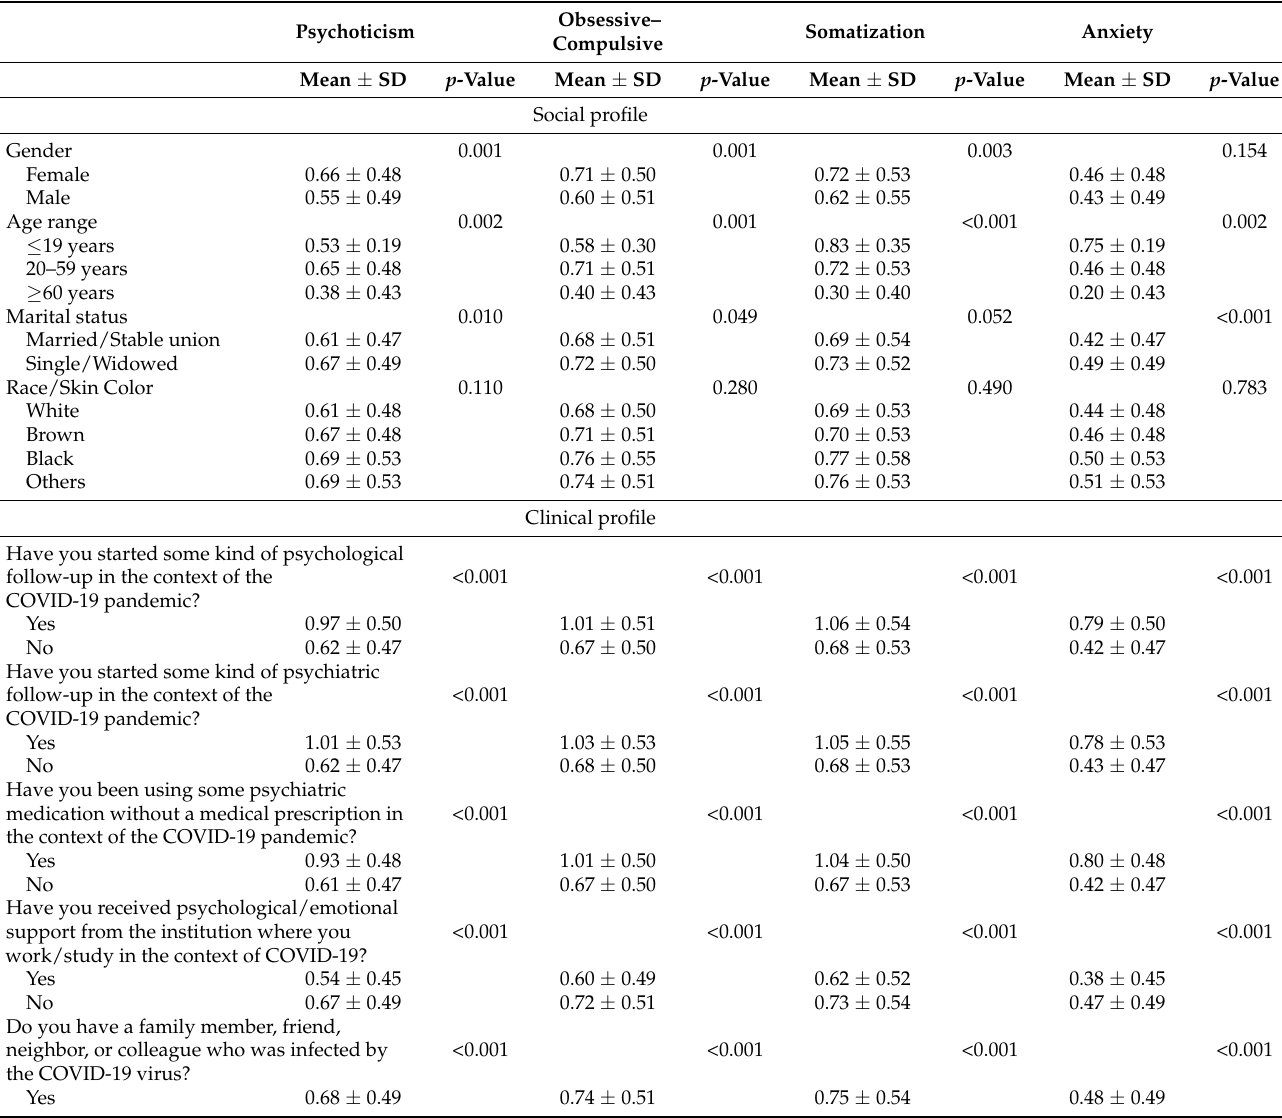
Table 3. Comparison between social and clinical profiles and psychopathological symptoms ( n =